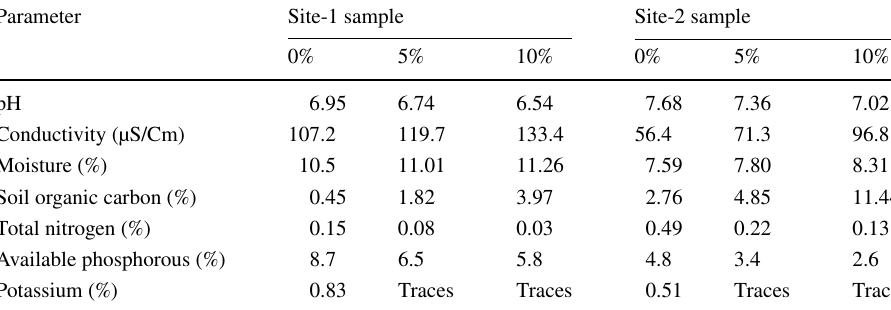
Table 4 Soil chemical characterization